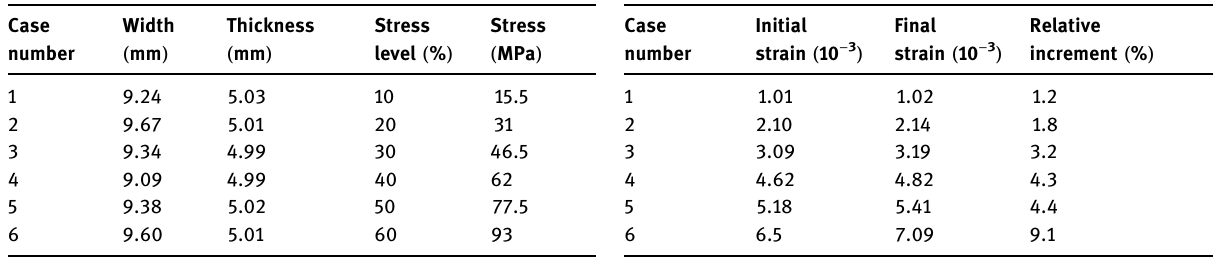
Table 4: The initial and fi nal strain state of the creep experiment